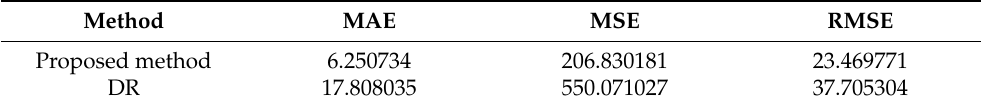
Figure 19. Identification result of AUV attitude angle. Table 6. Error comparison of different